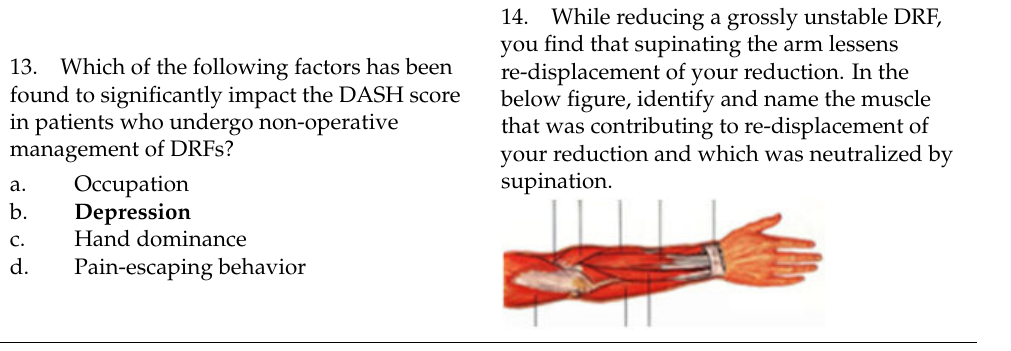
15. You are considering multi-planar external fixation versus non-operative management of a DRF in a 68-year-old male. When counseling this patient, which of the following is true regarding external fixation? a. Significantly better radial inclination radiographically compared to closed